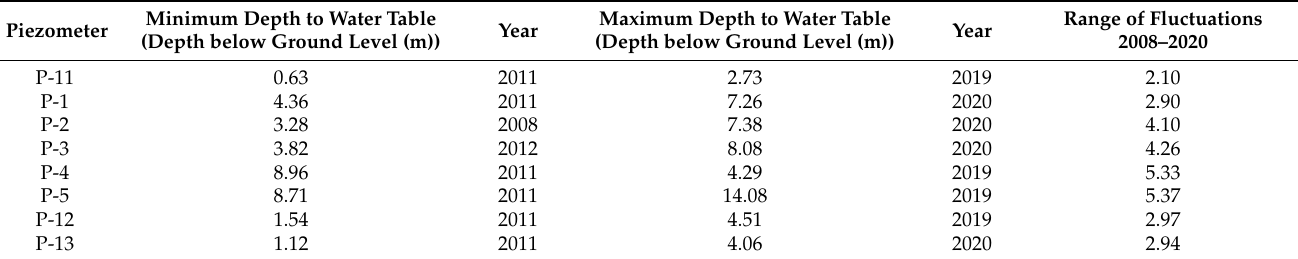
Table 6. The range of water table fluctuations in observation holes at the Jedwabno intake in the period 2008–2020. Minimum Depth to Water Table Piezometer (Depth below Ground Level (m))